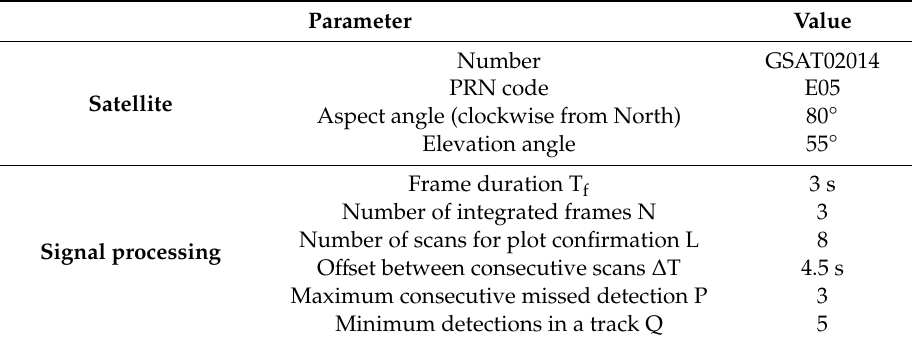
Table 3. Venice lagoon—experimental and signal processing